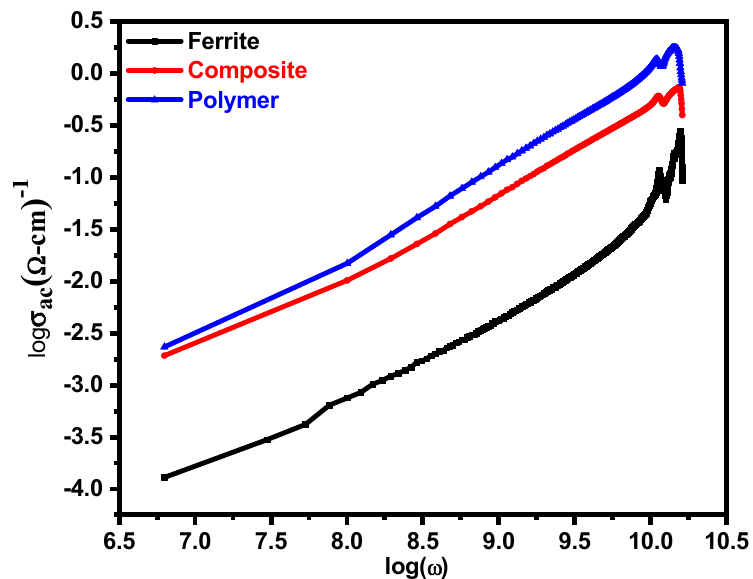
Figure 6. Modification in log σ with log ω of Y-type hexaferrite Sr 2 Co 2 Fe 12 O 22 , composite (Sr 2 Co 2 Fe 12 O 22 + PPy-DBSA) and polymer PPy-DBSA.